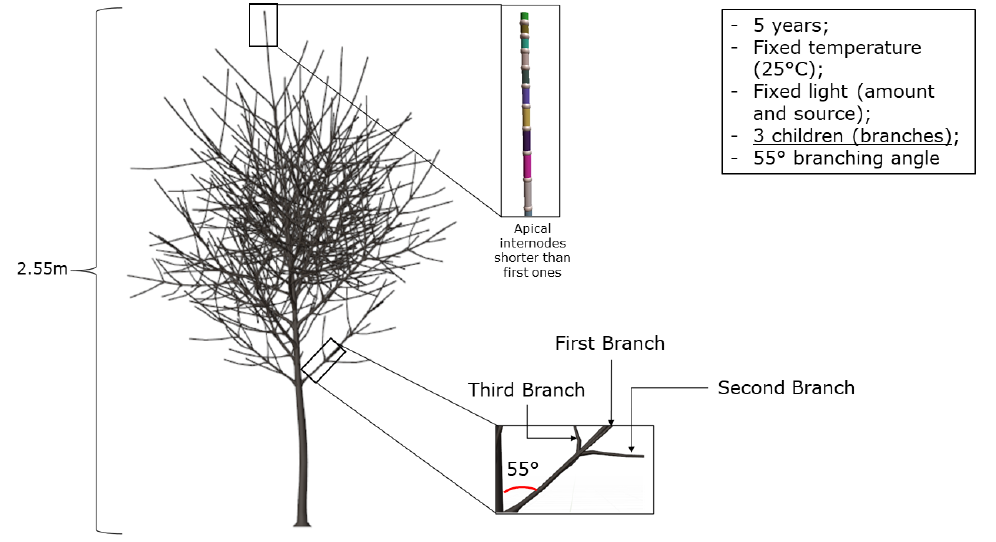
Figure 8. Tree growth with fixed temperature (25 °C), fixed light source (top) and amount, 55° branching angle and 3 children branches. The apical internodes are displayed with different colors for showing